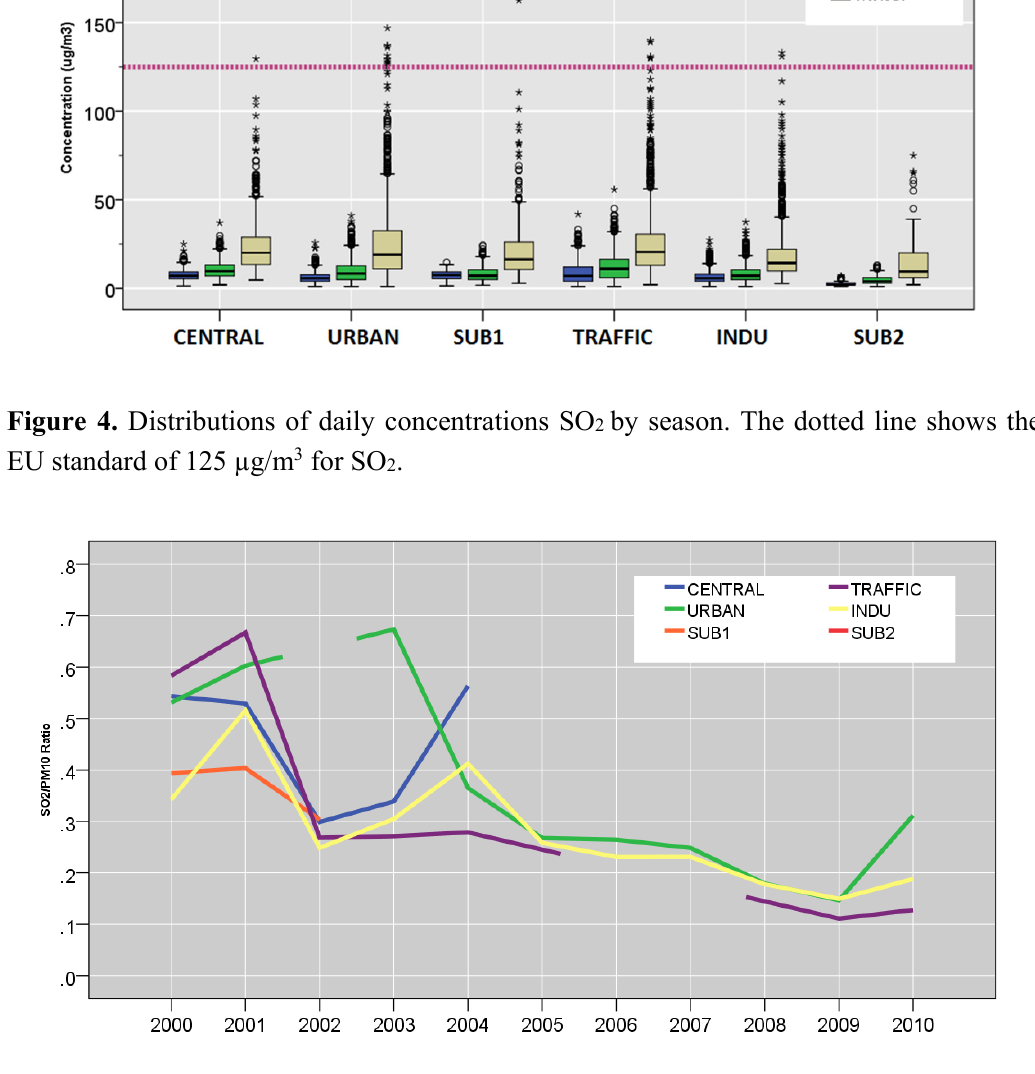
Figure 5. SO 2 /PM 10 concentration ratio according to site and